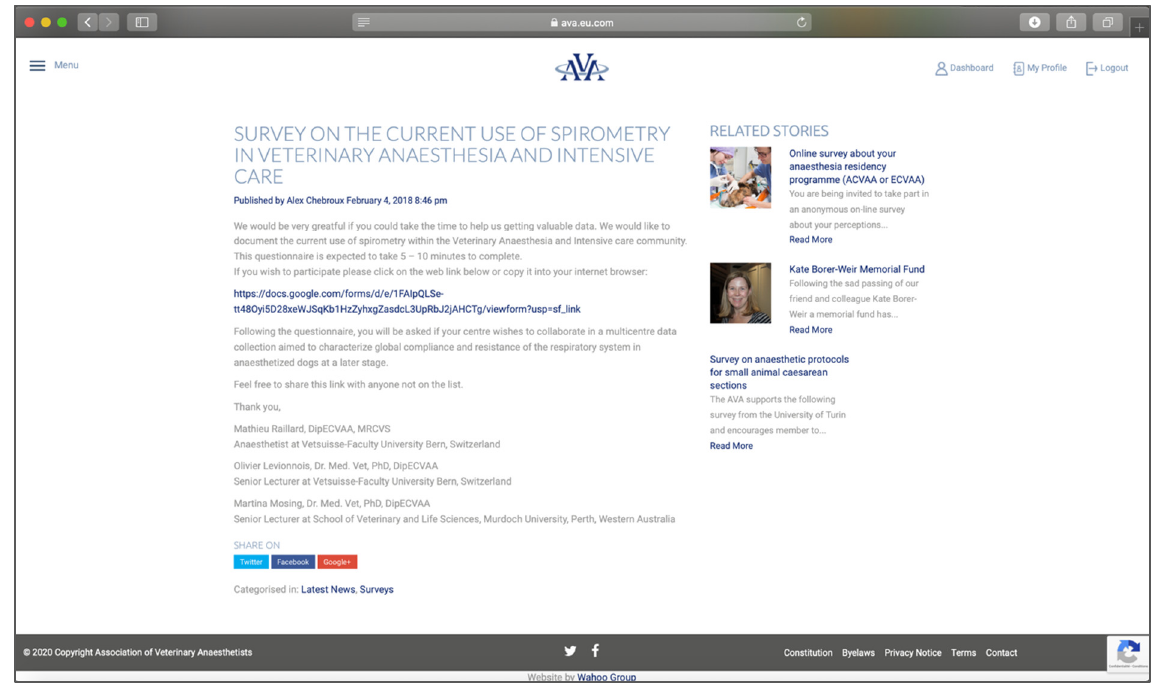
Figure A6. Example of survey announcement on the Association of Veterinary Anaesthetists (AVA) website.